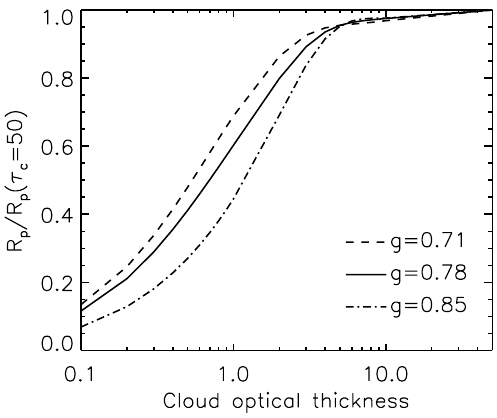
Fig. 1. Polarized reflectance R p as a function of cloud optical thick- ness τ c relative to its value at τ c = 50. Different linestyles indicate calculations made assuming different asymmetry parameters as in- dicated. Solar zenith, viewing and relative azimuth angles are 13 ◦ , 52 ◦ and 55 ◦ , respectively, leading to a scattering angle of 120 ◦